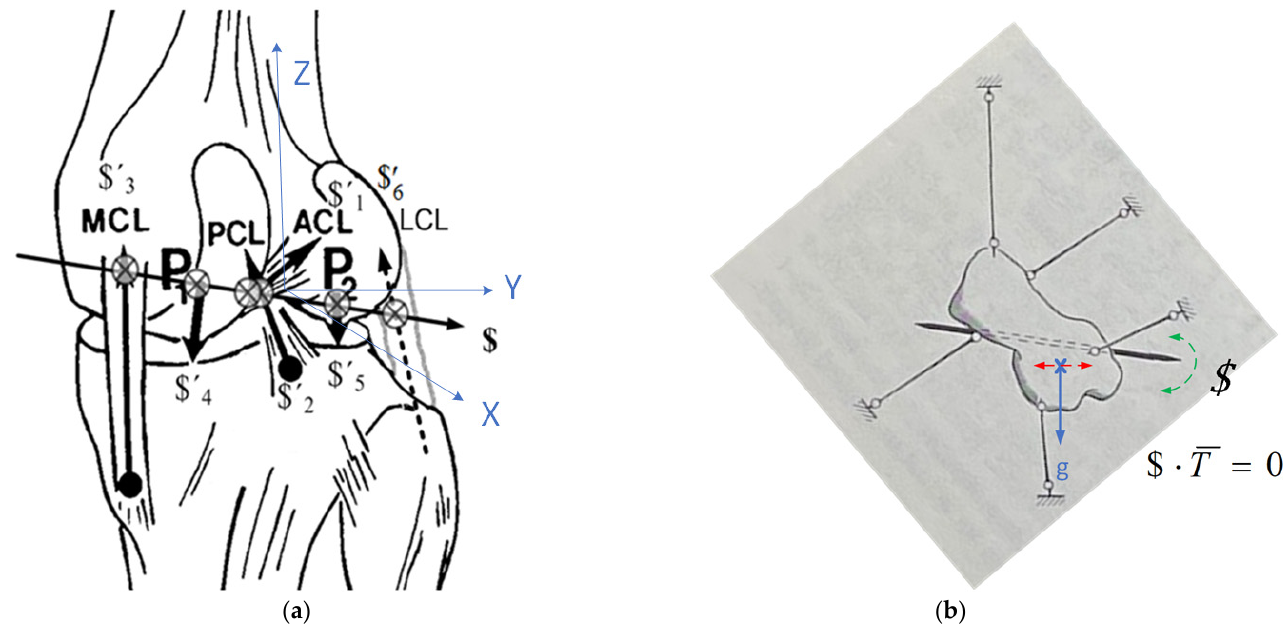
( b ) $ ,$ ,$ ,$ ,$ ,$ ′ ′ ′ ′ ′ ′ ), which are $ ,$ ,$ ,$ ,$ ,$ ′ ′ ′ ′ ′ ′ ), which are , $ (cid:48) , $ (cid:48) , $ (cid:48) , $ (cid:48) , $ (cid:48) ), which are 1 2 4 5 6 2 3 5 6 1 2 3 4 5 6 1 4 ⊗ ⊗ ’ s). The